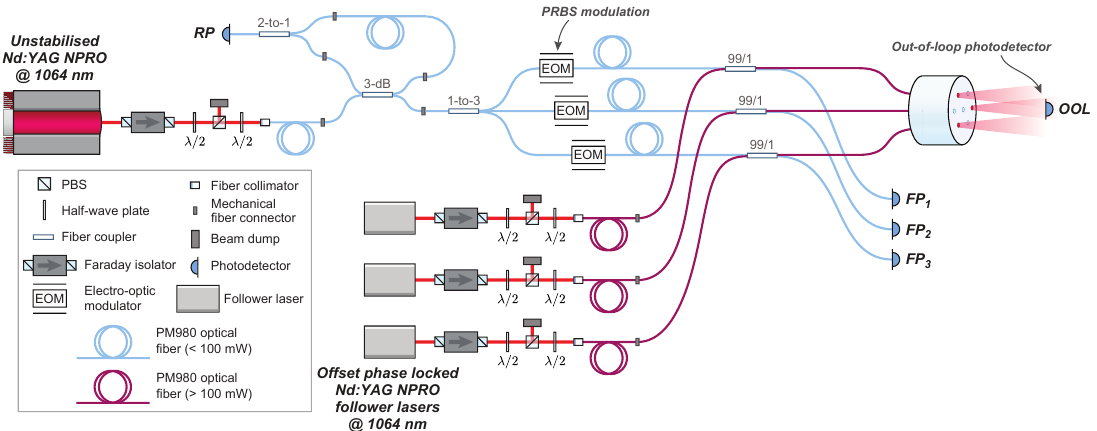
Figure 5. Experimental configuration of the optical system used to characterize the offset phase-locked